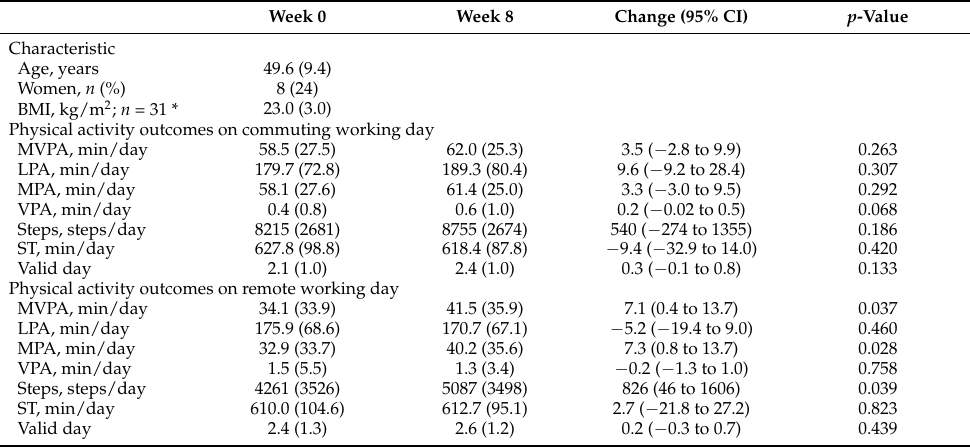
Table 4. Sub-domain analyses on commuting day and remote working day ( n = 34). Week 0 Week 8 Change (95% CI) p -Value Characteristic Age,